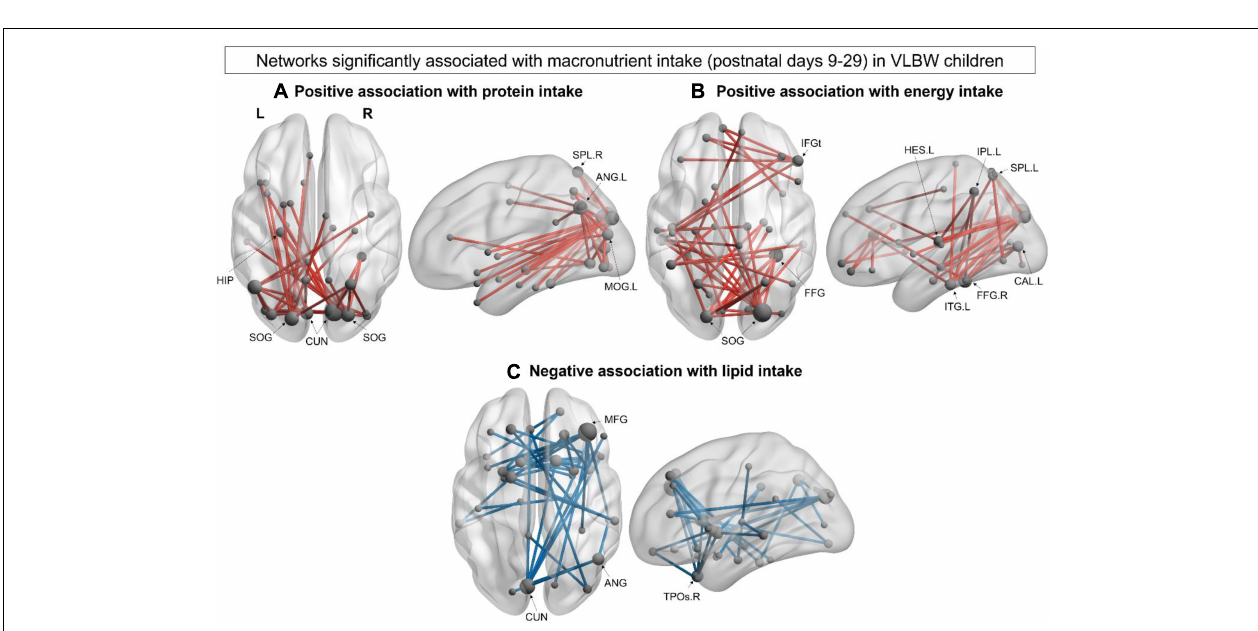
FIGURE 3 | Within-group network analysis. (A) Theta-band (4–7 Hz) network significantly associated with BASC-3 externalising problems (44 edges, 36 nodes, p corr = 0.039) in VLBW children. (B) Alpha-band (8–14 Hz) network significantly associated with BASC-3 internalising problems (41 edges, 32 nodes, p corr < 0.001). (C) Alpha-band network significantly associated with the BASC-3 behavioural symptoms index (38 edges, 33 nodes, p corr = 0.002). All of these were negative correlations, such that reduced network connectivity was related to increased behavioural difficulties. Node size is scaled by degree.